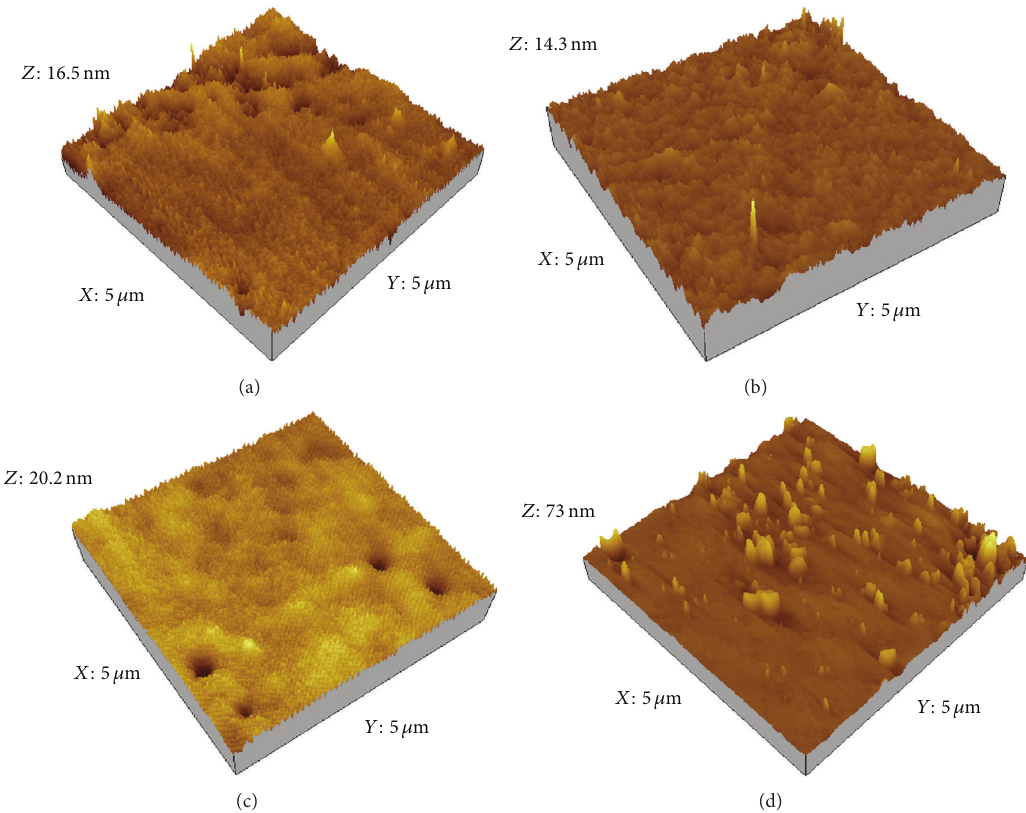
Figure 4: AFM images for (a) PAH monolayer onto quartz substrate, (b) SinA monolayer film onto PAH monolayer without UV irradiation (c) SinA monolayer after UV irradiation for 15h, and (d) SinA monolayer after UV irradiation for 24h.